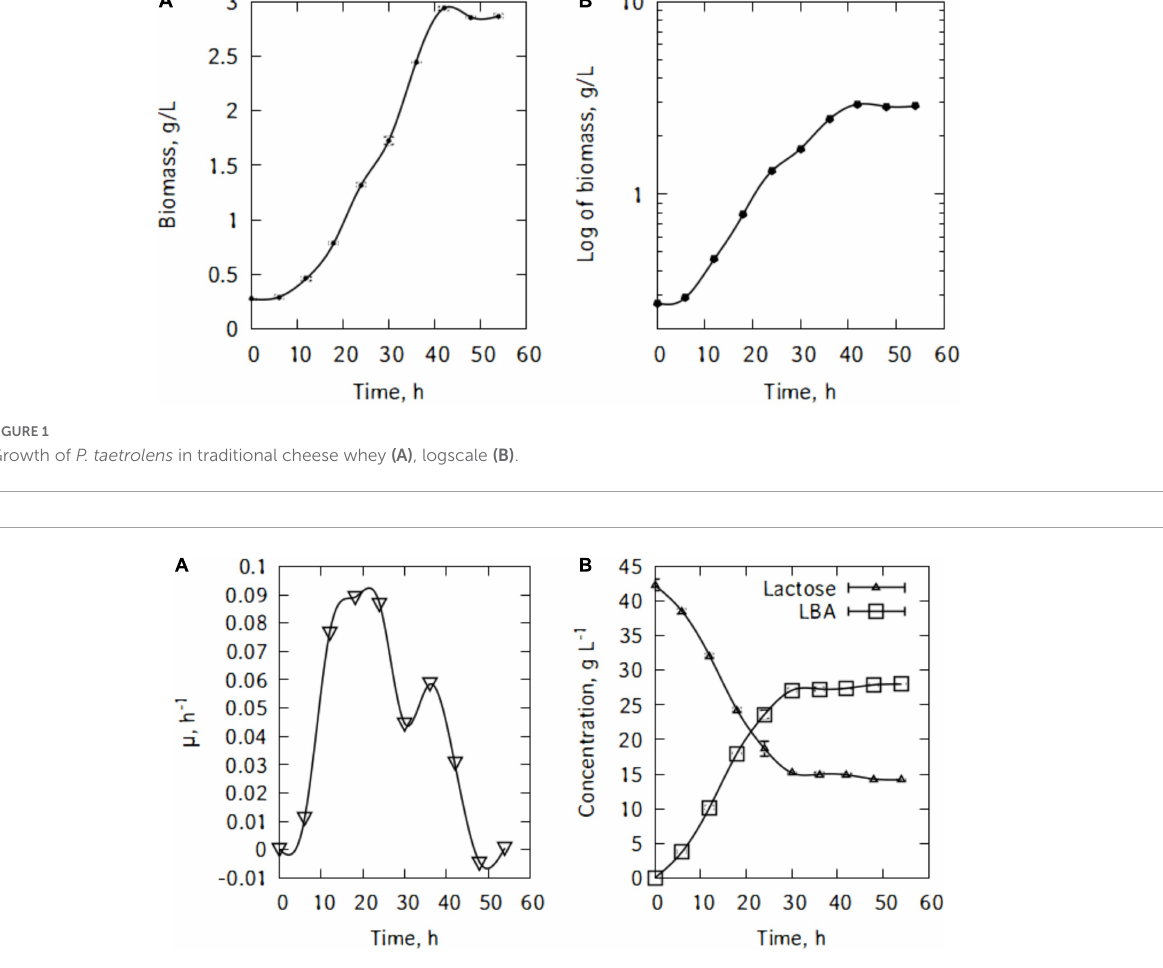
Figure 6B suggests a linear relation between q p and µ